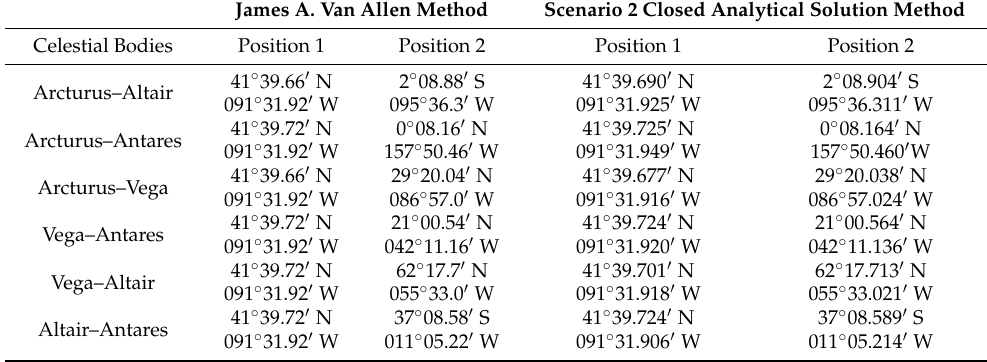
Table 7. The results of Example 3.